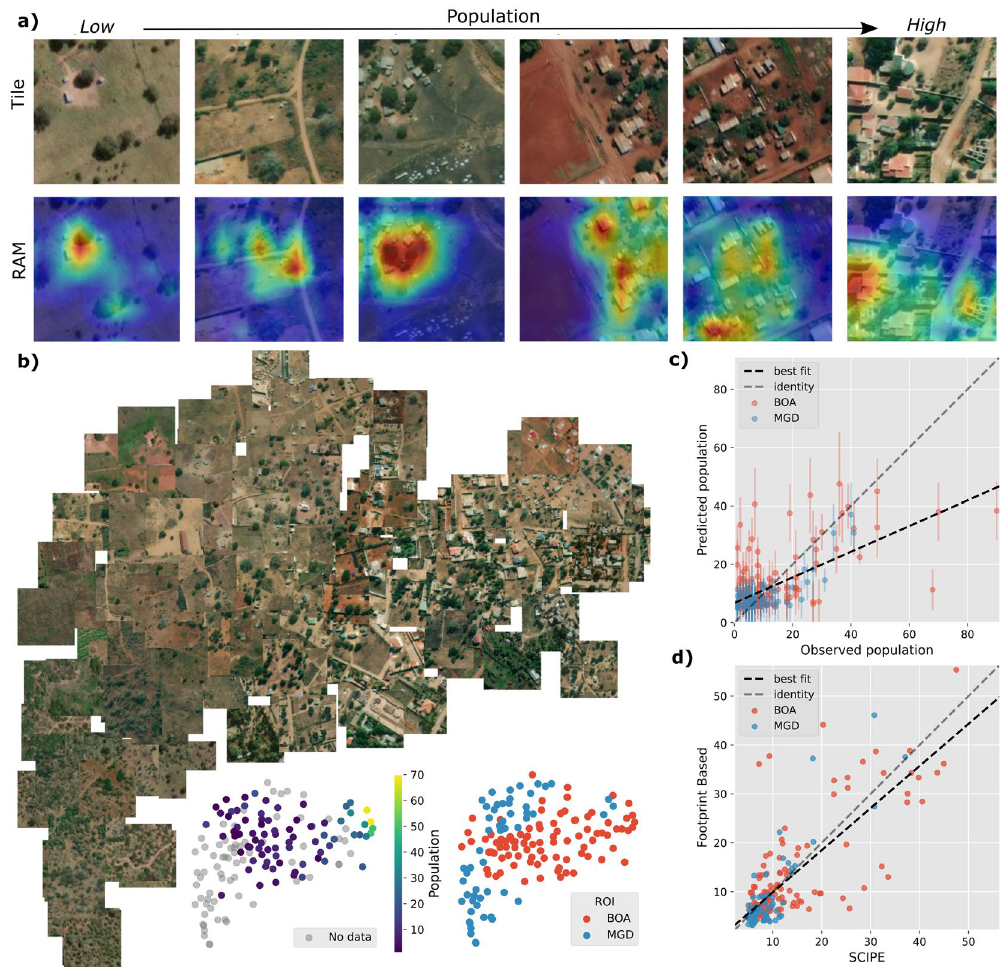
Figure 5. Activation maps, embedding visualization, and comparison of SCIPE with microcensus data and footprint based estimates. ( a ) Tiles and their associated regression activation maps (RAMs) from fine-tuned Barlow Twins model. ( b ) Plot of t-SNE embeddings of representations from Barlow Twins for 75 random tiles and 75 microcensus tiles from Boane and Magude (main), with embeddings coloured by population (bottom left) and region (bottom right). ( c ) Predicted over observed plot over microcensus with prediction uncertainty. ( d ) Comparison between SCIPE estimates and building footprint based estimates on the microcensus grid